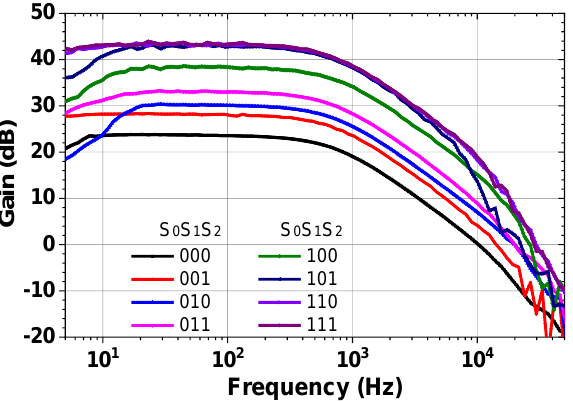
Figure 21. Measured frequency response of the ECG channel for eight gain settings.